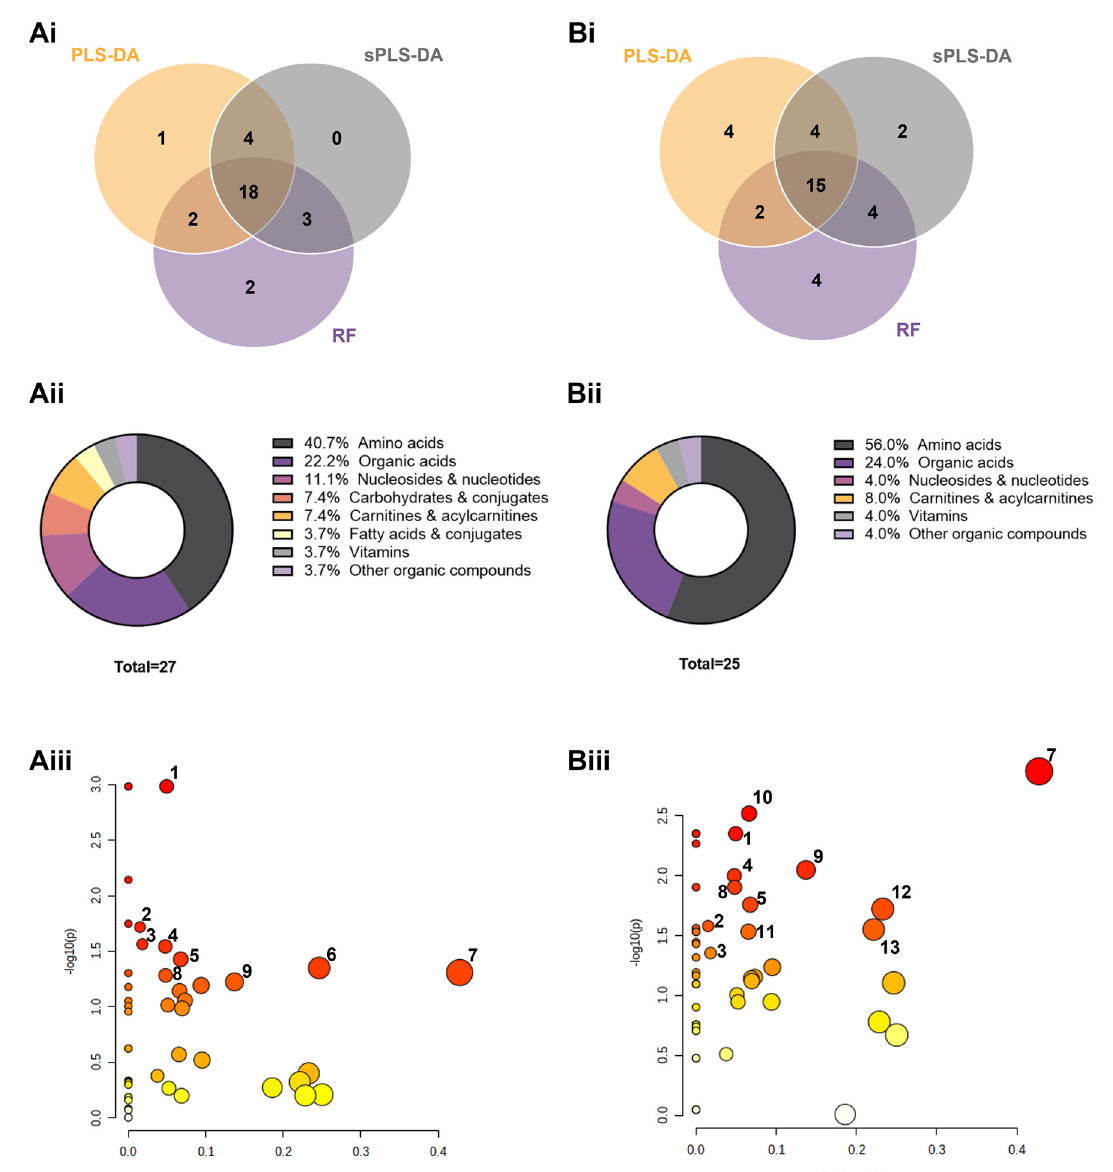
Figure 6. Supervised learning and pathway analysis from metabolic footprinting of patient-derived explant cultures reveals discriminating metabolic features between high- (HR) and low-responders (LR). For ( A ) untreated control and ( B ) drug combination-treated HGSC datasets at day 14, supervised models (PLS-DA: partial least-squares discriminant analysis; sPLS-DA: sparse PLS-DA; RF: random forests) revealed ( i ) consistent top metabolic features discriminating HR from LR and ( ii ) respective metabolite classes. ( iii ) Pathway analysis of HR vs. LR shows significantly altered pathways for fatty acids metabolism (1, 2), amino acids metabolism (3, 4, 6, 7, 8, 9) and pyrimidine metabolism (5) pathways. A list of metabolites and respective classes, as well as altered pathways and respective metabolites, are included in Supplementary File S4, (color scale and symbol size reflect the combination between the p-value and the pathway impact, respectively).